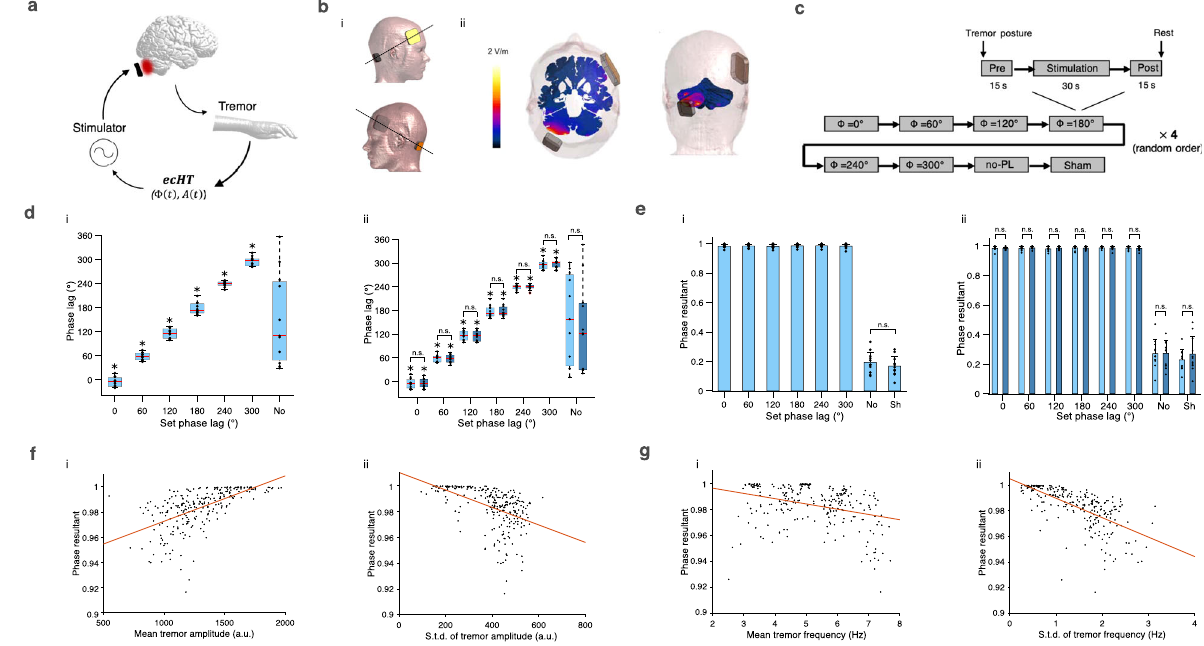
Fig. 2 Stimulation of the cerebellum phase-locked to ET movement. a Neuromodulation concept. ET is suppressed by perturbing its pathologic synchrony via cerebellar stimulation phase-locked to hand tremor oscillation. ET oscillation is measured via a motion sensor, instantaneous attributes of the oscillation (i.e. amplitude A ( t ), phase Φ ð t Þ ), are computed in real-time using ecHT, and electric currents are delivered, transcranially, to the cerebellum at a fi xed phase lag. b Electrode con fi guration and cerebral electric fi elds distribution. (i) Stimulating currents were applied via a small skin electrode placed over the cerebellar hemisphere ipsilateral to measured hand tremor (10% axial nasion-inion distance lateral to inion) and a larger electrode placed over the contralateral frontal cortex (between F3 and F7 or F4 and F8 of the international 10 – 20 system). (ii) Finite element method (FEM) modelling of induced electric fi eld for current amplitude of 2 mA. c Experimental design. d Phase-lag between stimulating currents and tremor movement vs. set phase lag during (i) whole stimulation period and (ii) 1st half (light blue) and 2nd half (dark blue) of the stimulation period. ‘ No ’ , control sinusoidal current at the tremor frequency but without phase-locking; shown are box, 25 and 75% percentile values; horizontal red line, median value; horizontal black lines, data range; black markers, participants ’ values; * p < 0.05, two-sided Omnibus test; n.s. non-signi fi cant; n = 11 participants. See Supplementary Table 2 for between conditions statistics. e Mean phase resultant vector length vs. set phase lag during the same periods as in ( d ); shown are mean ± st.d.; markers show participants ’ values; ‘ No ’ , stimulation with no phase locking; ‘ Sh ’ , sham stimulation. two-sided ANOVA with post-hoc analysis using Wilcoxon signed-rank test; n = 11 participants; See Supplementary Table 3 for full statistics. f Mean phase resultant vector length vs. (i) tremor amplitude, (ii) st.d. tremor amplitude; shown black markers are trials ’ mean values. Red line, linear regression, (i) line slope m = 0.59, p < 10 − 5 , Pearson correlation test, (ii) m = − 0.49, p < 10 − 16 . g Same as ( f ) but (i) tremor frequency, m = − 0.33, p < 10 − 7 ; (ii) st.d. tremor frequency, m = − 0.66, p < 10 − 32 . Source data are provided as a Source Data fi